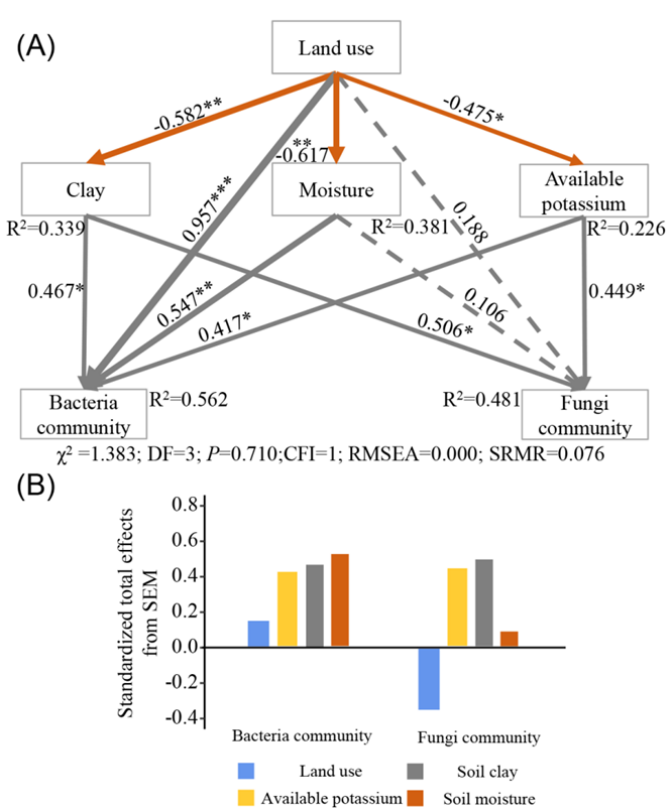
available phosphorus.